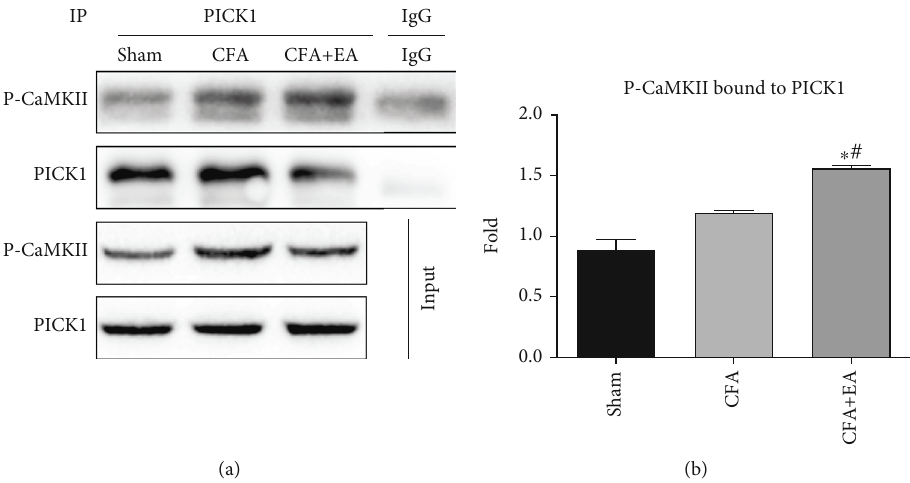
Figure 3: E ff ects of EA on the formation of pCaMKII-PICK1 complex. (a) Representative western blot images of P-CaMKII and PICK1 by CO-IP. (b) Statistical analysis of pCaMKII-PICK1 complex. Results represent the mean ± SEM ( n = 4 /group). ∗ P < 0 : 05 vs. sham group; # P < 0 : 05 vs. CFA group.